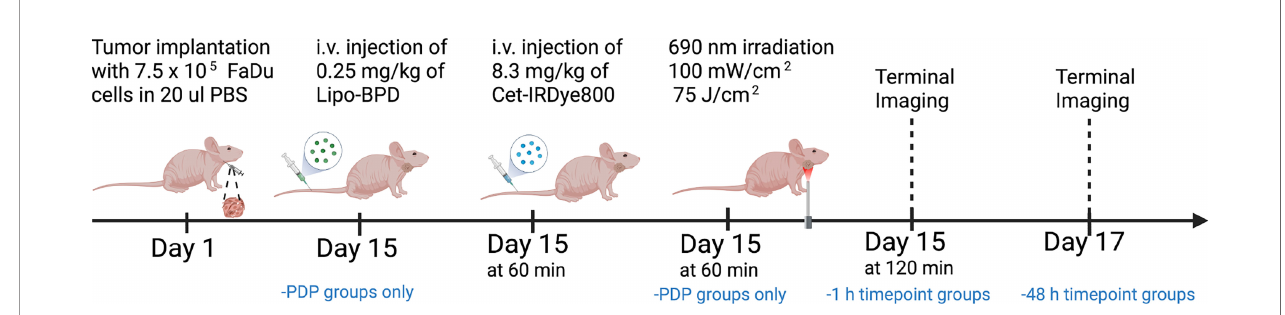
FIGURE 2 | Schematic representation of the procedures and timeline of the in vivo studies involving the PDP process and imaging of Cet-IRDye800 in FaDu human head and neck